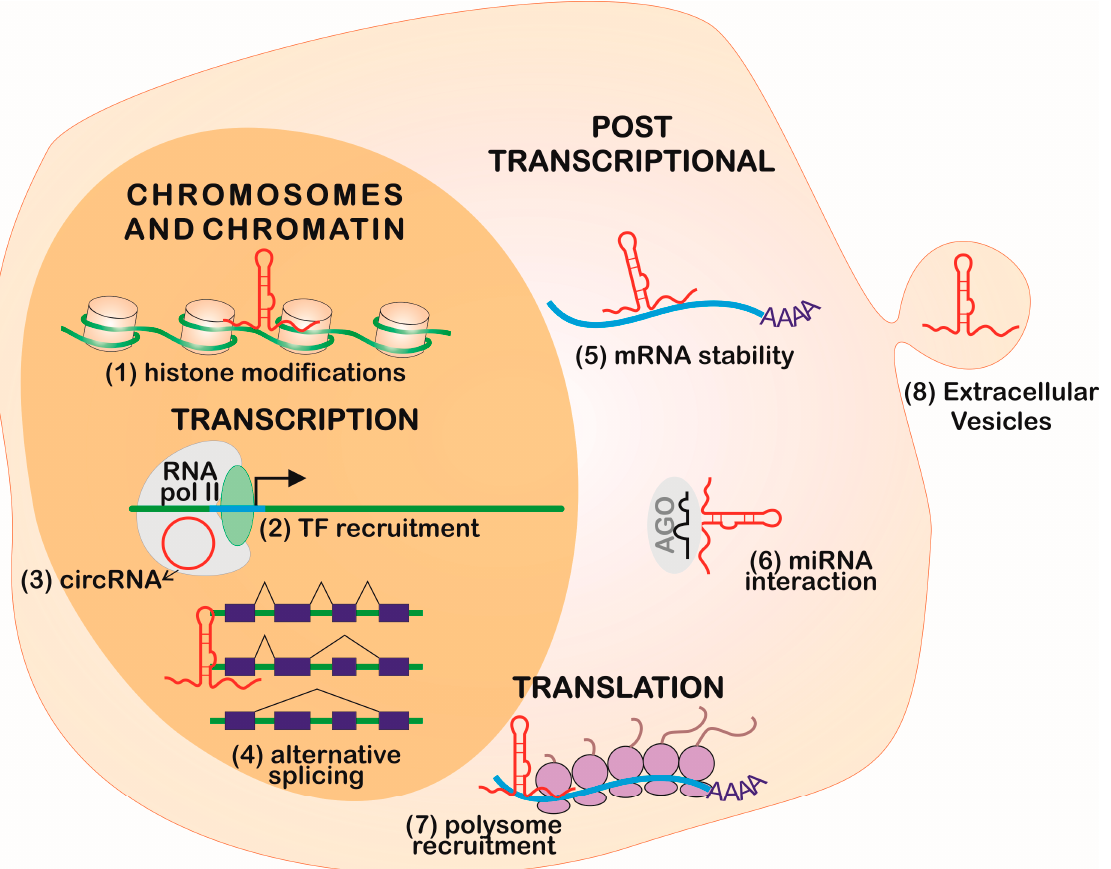
Figure 2. LncRNA participation in gene expression regulation. Many types of lncRNA controls can occur to regulate gene expression, such as: (1) chromatin and chromosome condensation through histone modifications, (2) transcription factors (TF) direct recruitment, (3) binding to RNA polymerase (pol) II, (4) alternative splicing, (5) mRNA stability, (6) miRNA availability, (7) polysomes recruitment, and (8) modulation of gene expression in neighbor cells through packaging into extracellular vesicles.